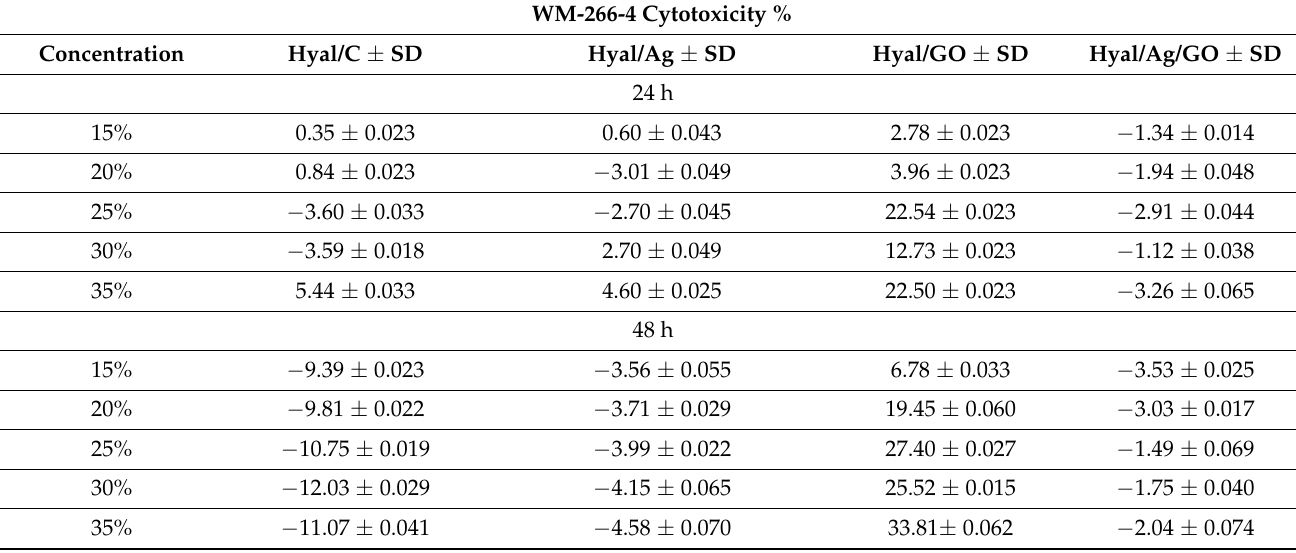
Table 5. Cytotoxycity of nanoparticle composites on WM-266-4